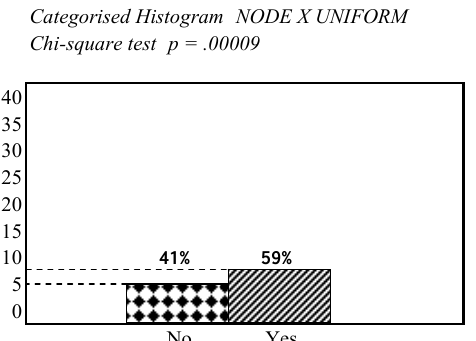
Figure 1: Arts, crafts and collectables; general; home and beauty